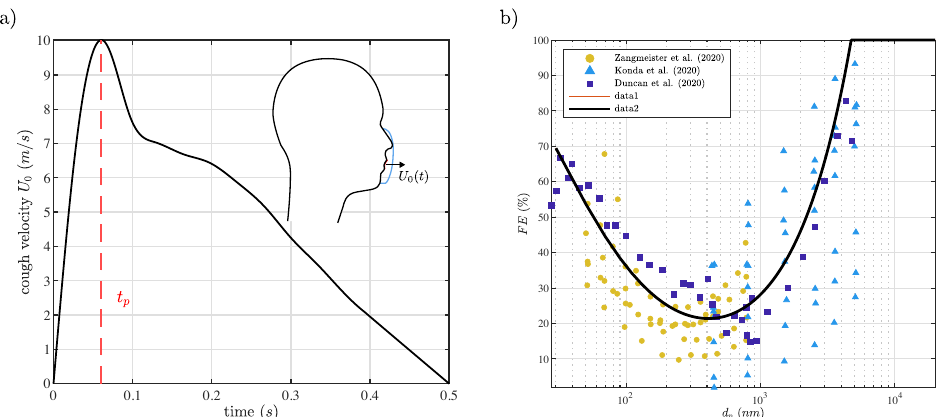
Figure 2. ( a ) Cough jet velocity evolution. Inset shows the location of the impulsively started cough-jet condition. ( b ) filtration efficiency of different fabric masks as a function of particle size. A second-order rational polynomial is fitted to represent the mean of the data from literature [45–47] for each particle